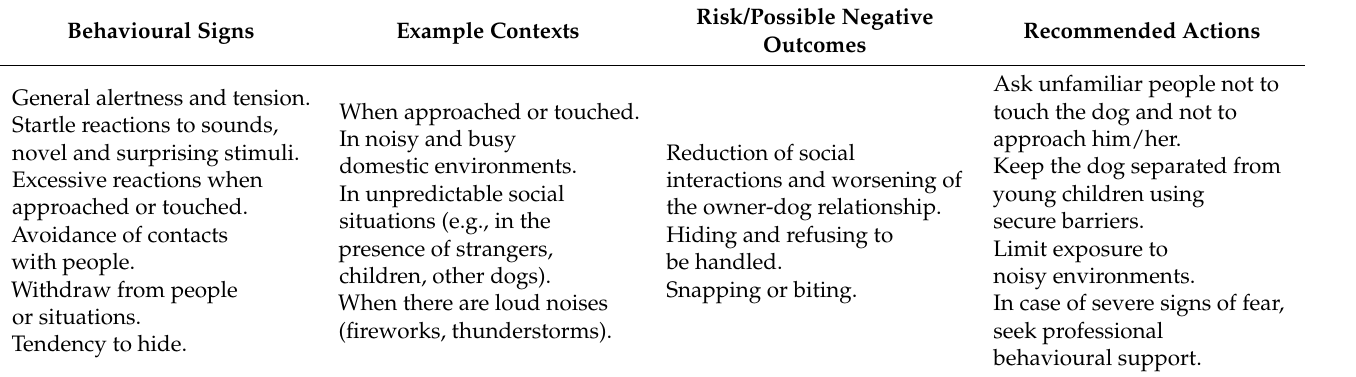
Table 2. Increased vigilance and agitation during corticosteroid treatment. Behavioural signs, examples of possible situations and contexts, possible outcomes, and recommended